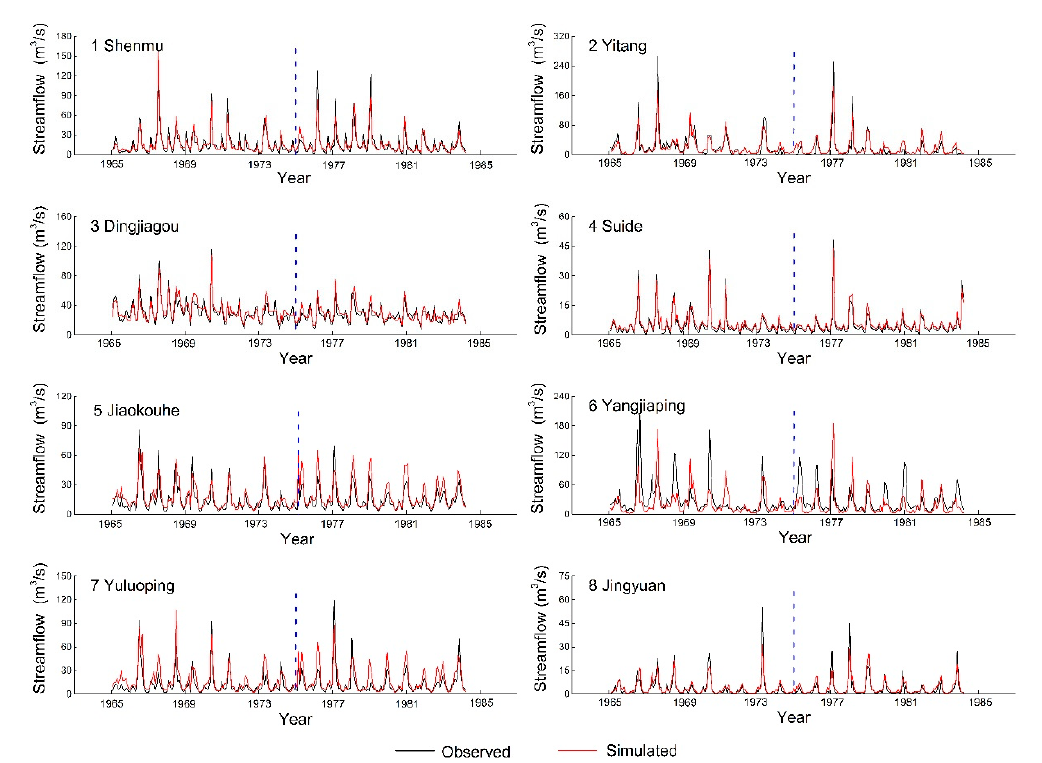
Figure 2. Observed and simulated monthly streamflow during calibration period (1965–1974) and